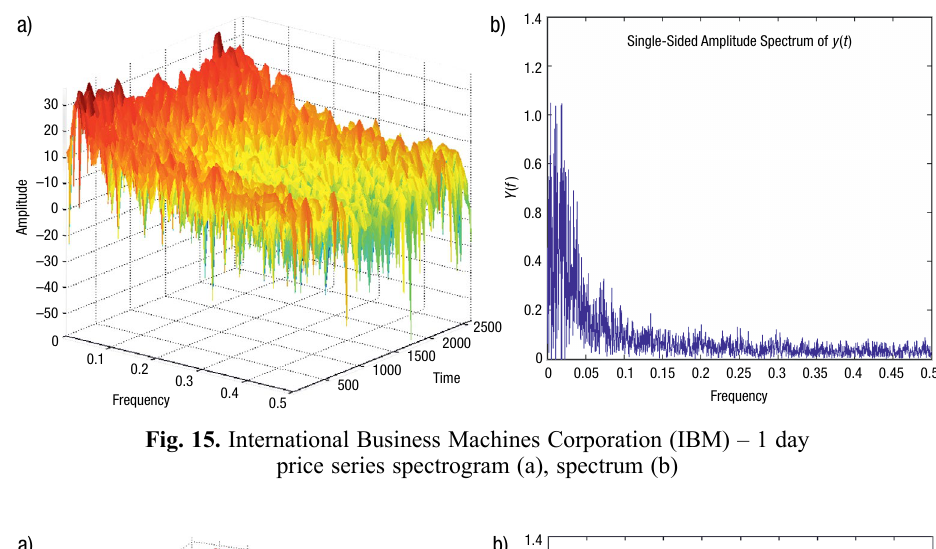
Fig. 15. International Business Machines Corporation (IBM) – 1 day